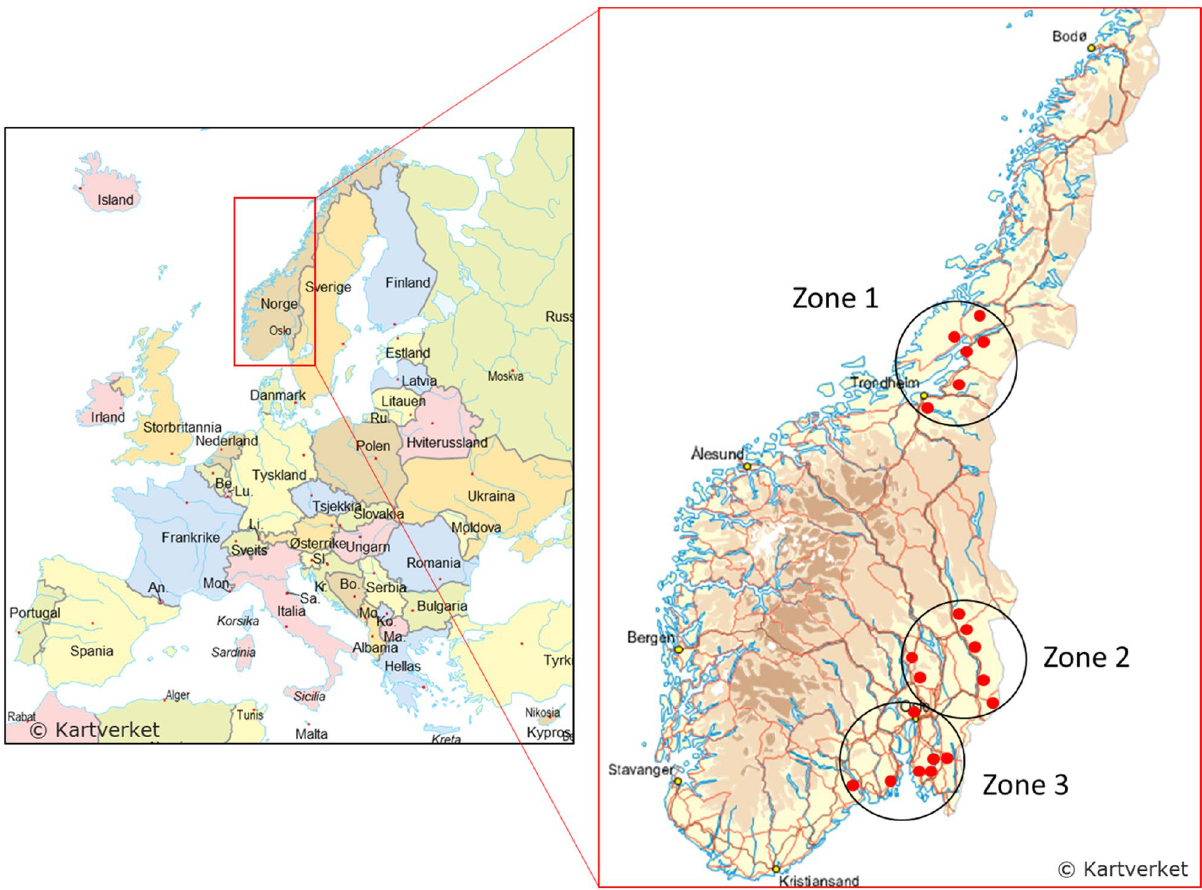
Figure 6. Map of the sampling locations. The sampling site spun over three geographically and climatically different districts; zone 1: the central coastal Norway (Trøndelag), zone 2: eastern inland of Norway (Viken, Innlandet), and zone 3: southeast Norway (Oslo, Viken, Vestfold and Telemark). All districts are located north of 59 degrees northern latitude. The figure consists of sections of illustration maps of Europe and Norway, respectively, provided under Public License by Geonorge Version 12.5.557 from https:// kartv erket. no/ en/ on- land/ kart/ illus trasj onska rt, modified with the inclusion of red, filled circles representing each of the 20 companies included in the study and black circles representing each of the different zones with the belonging zone